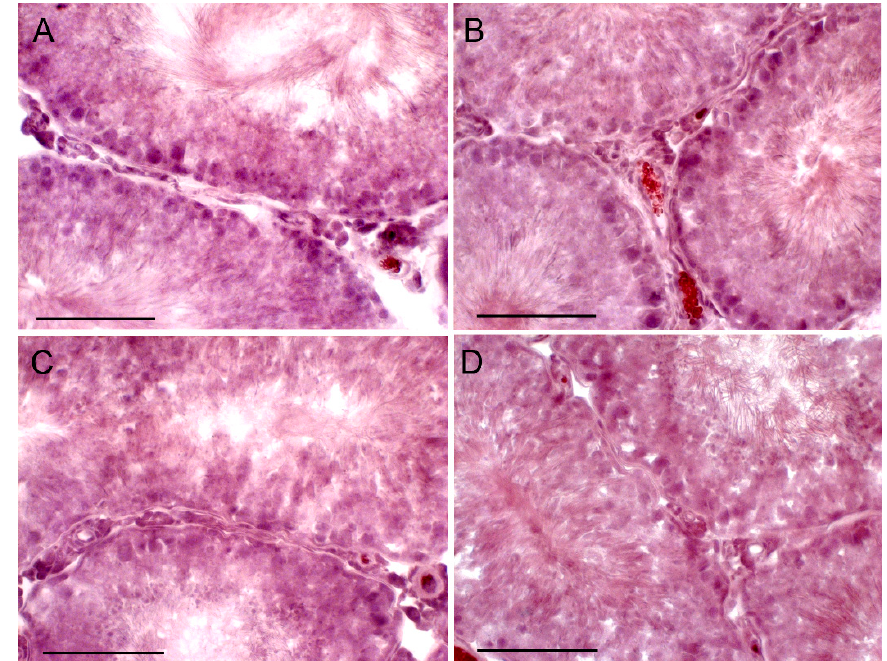
Figure 6. The morphology of the seminiferous tubules in the testis of aging rats, and the effect of a five-day treatment with TP4/2 and hCG. A —Aging+dmso, B —Aging+TP, C —Aging+saline, D — Aging+hCG. The histology of the rat testis was evaluated using the staining of the testis section with Ehrlich hematoxylin and Eosin G. Scale bars, 100 μ m.